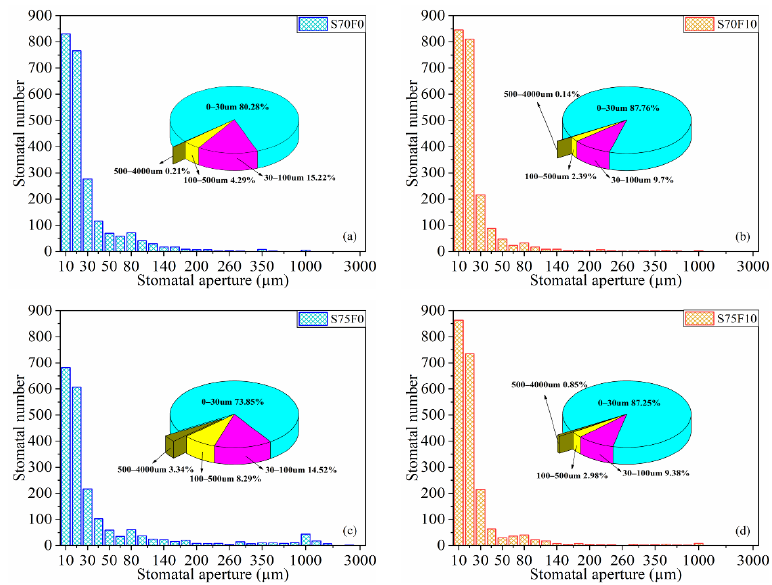
Figure 11. Distribution and proportion of the pore sizes of specimens ( a ) S70F0; ( b ) S70F10; ( c ) S75F0; ( d ) S75F10.